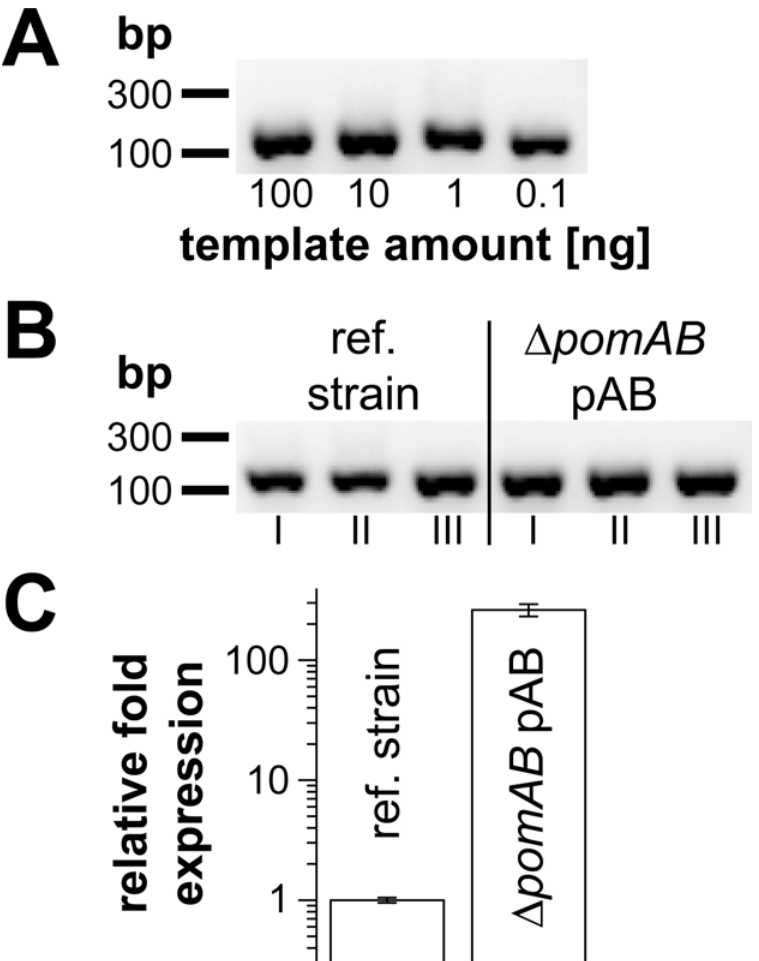
Fig 2. Transcription level of plasmid-encoded versus chromosomally encoded pomB in V . cholerae determined by qRT-PCR. A: analysis of amplification products obtained from qRT-PCR reactions with template (cDNA) amounts of 100 ng, 10 ng, 1 ng and 0.1 ng by agarose gel electrophoresis. The efficiency of the primer pair “ pomB fwd ” / “ pomB rev ” was 115% with R 2 = 0.998, as calculated using the CFX Manager software (Bio-Rad). A 100 bp DNA ladder (GeneRuler, Thermo Scientific) served as molecular size marker. B: The correct size (134 bp) of the products from the qRT-PCR reactions (technical triplicates, I – III) was confirmed by agarose gel electrophoresis. C: Relative transcription level of pomB in the V . cholerae reference strain and in V . cholerae Δ pomAB pAB induced with 10 mM L-arabinose. For both strains, qRT-PCR reactions were performed in technical triplicates. Transcription levels of pomB were calculated using the